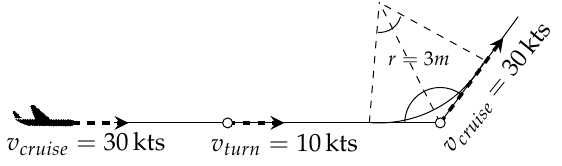
Figure 4. Speed changes employed by an aircraft in preparation for a